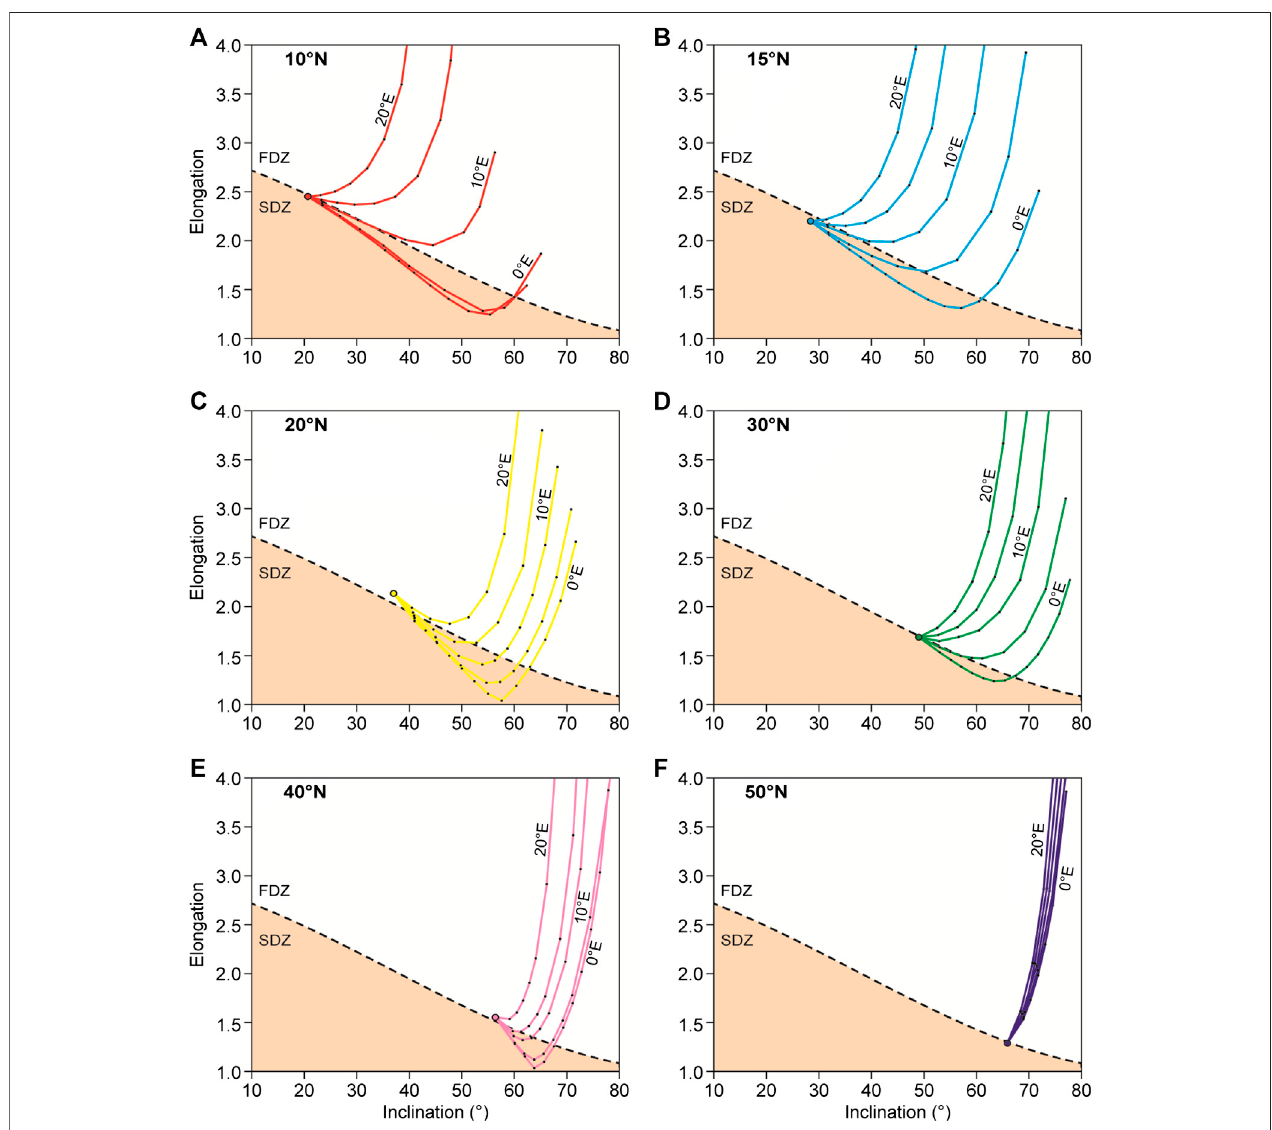
FIGURE 5 | Effect on the elongation/inclination (E/I) pairs of the TK03.GAD directions sets distribution varying the angle between the average declination and the eigenvectors 3 (i.e.,shorteningdirection)ofthestrain(S)matrix(angles (cid:1) 0 ° ,5 ° E,10 ° E,15 ° E,20 ° E).Colorsareasin Figures3 , 4 ,andthelatitudeofthesetisindicatedfor clarity (bold).